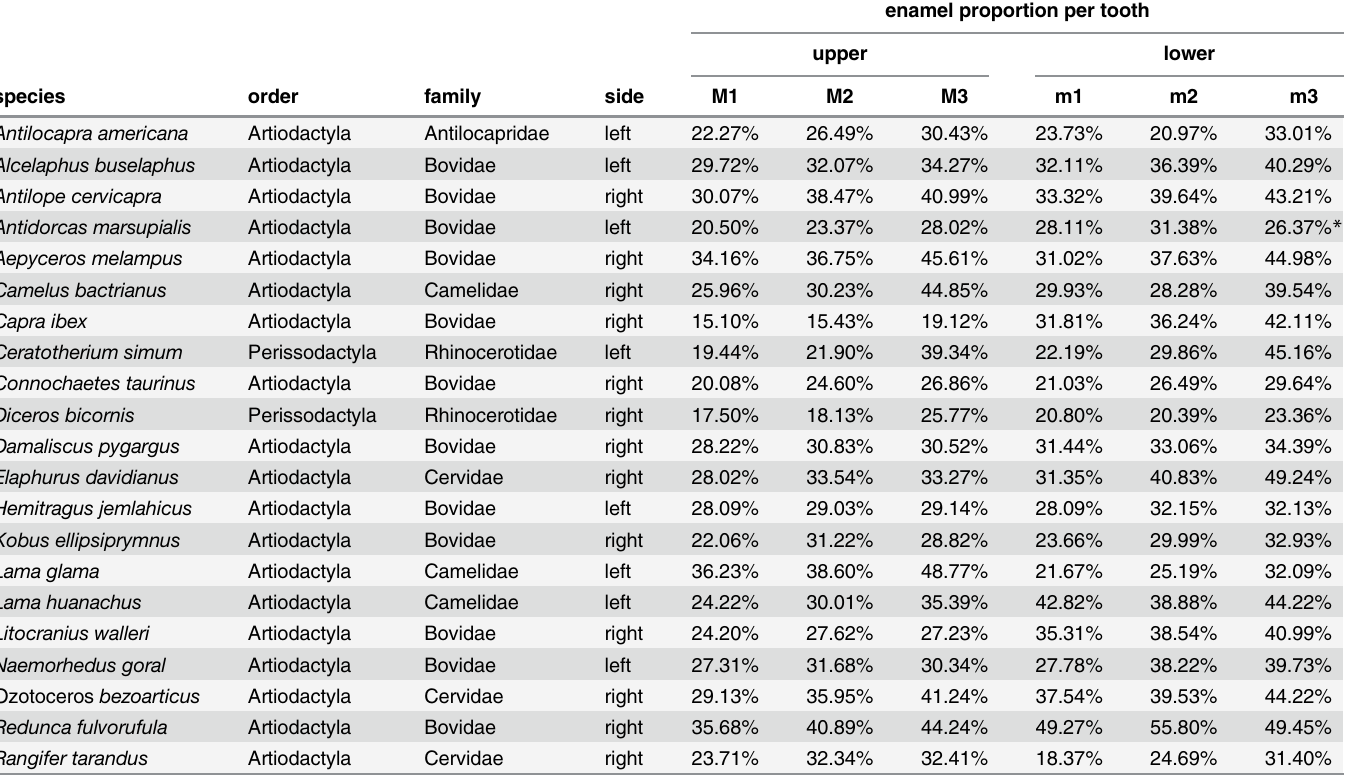
Table 1. Enamel proportion for each tooth